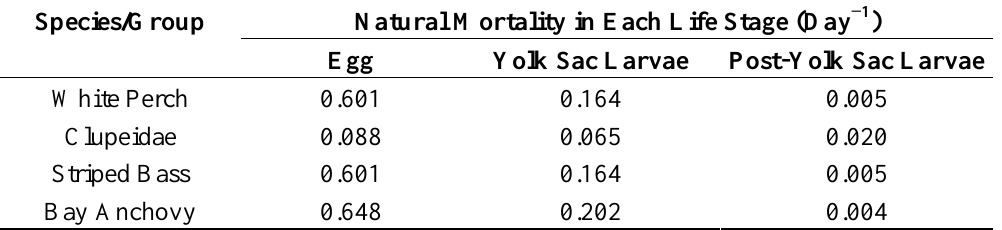
Table 4. Natural mortality rates.